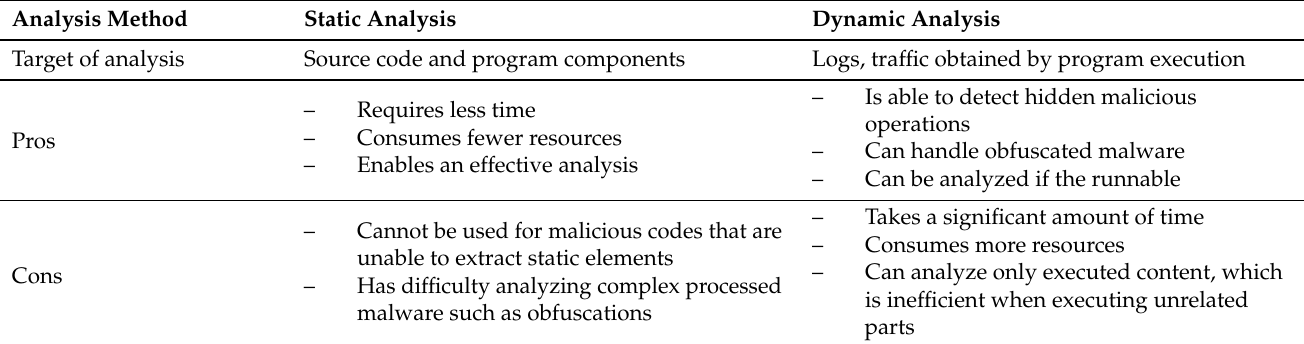
Table 1. A summary of static and dynamic